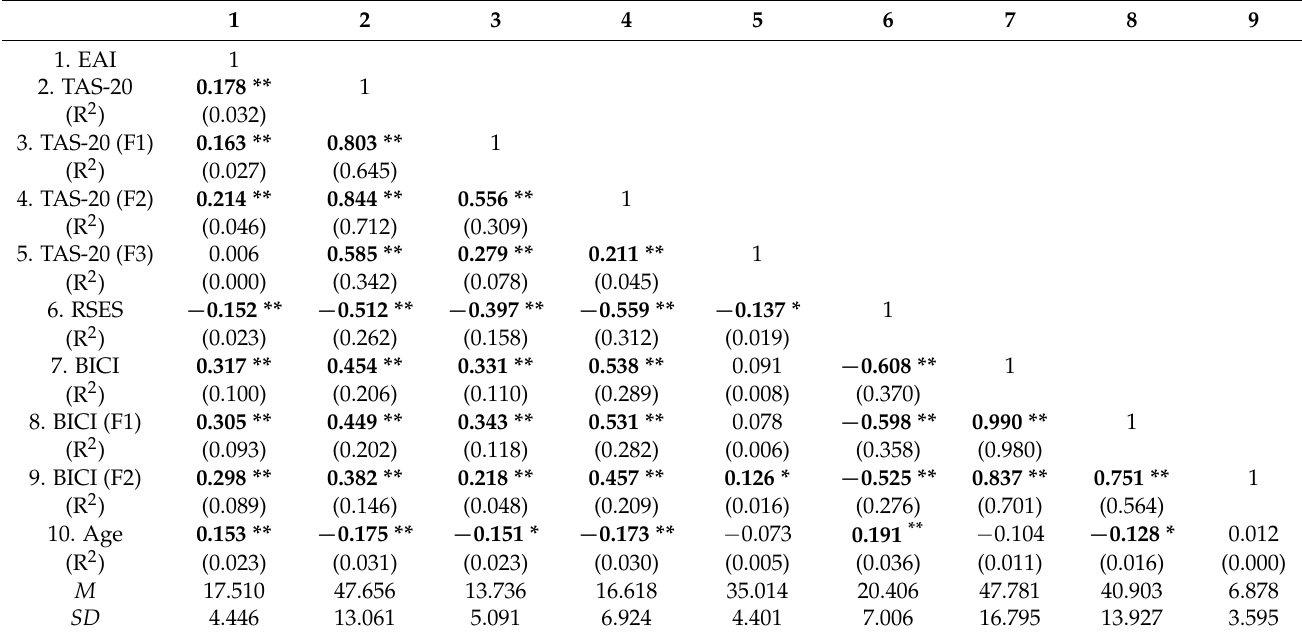
Table 2. Pearson’s correlation, means, and standard deviations of the study